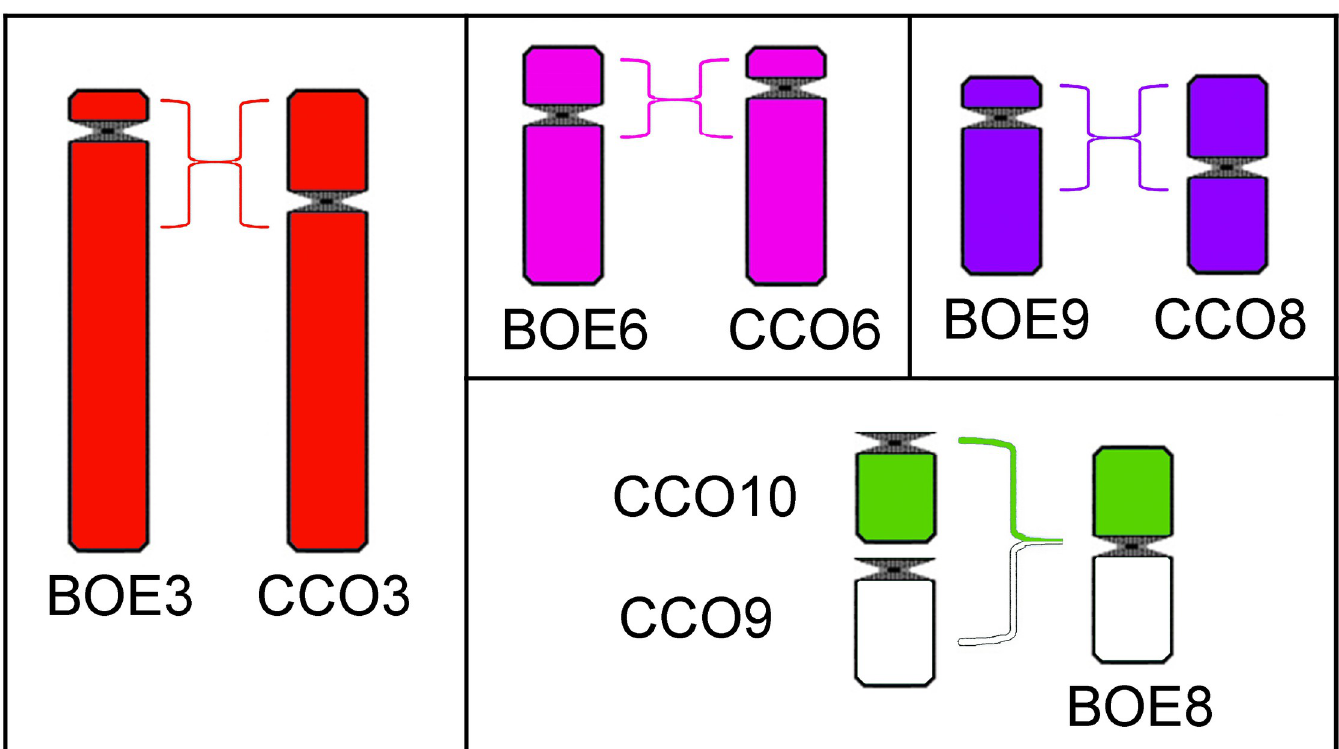
Fig 6. Idiogram for chromosomal pairs that have undergone pericentric inversions or centric fusions. Pericentric inversion that differ: A) BOE3 from CCO3; B) BOE6 from CCO6; C) Pericentric inversion of the metacentric CCO8 and the acrocentric BOE9; D) Fusion of CCO9 and CCO10 giving rise to BOE8.